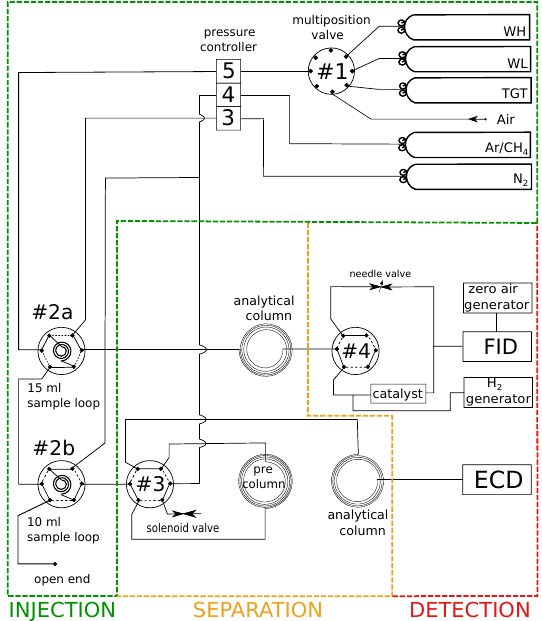
Figure 2. Schematic of the GC system setup (gas flow) at the Puy de Dôme